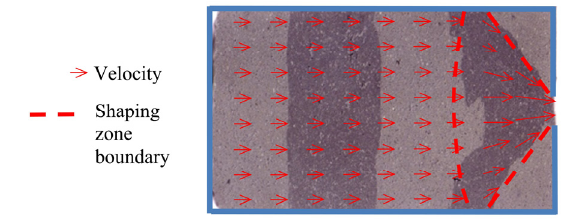
Figure 4. Example of flow profile in the extruder including a localization of the shaping